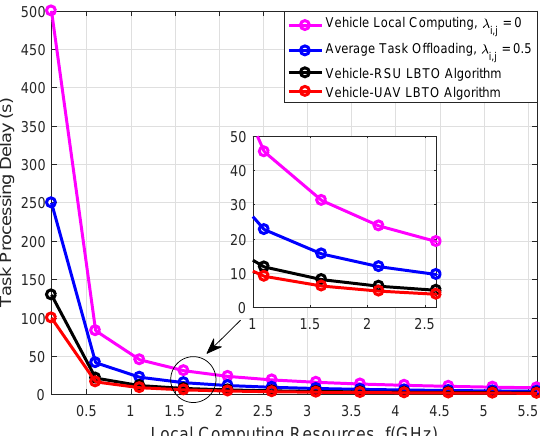
Figure 5. Comparison of the task processing delay with respect to the local computation resources under different